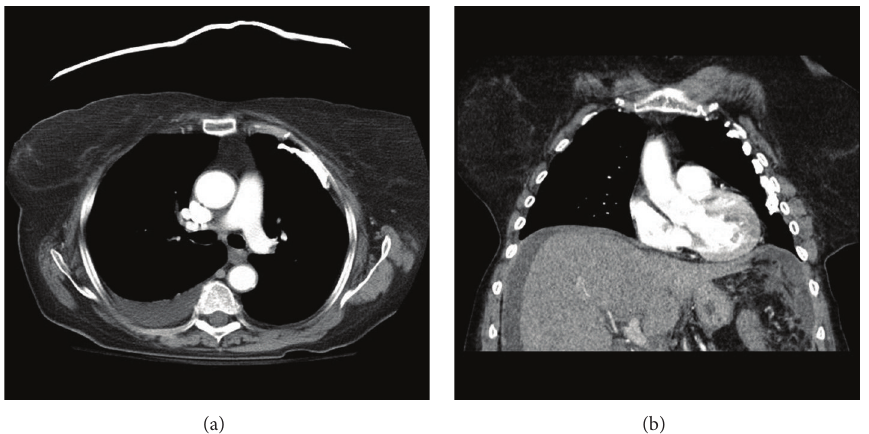
Figure 1: CT of the chest shows right-sided pleural effusion (a) and calcified pleural plaques in the left hemithorax (b).